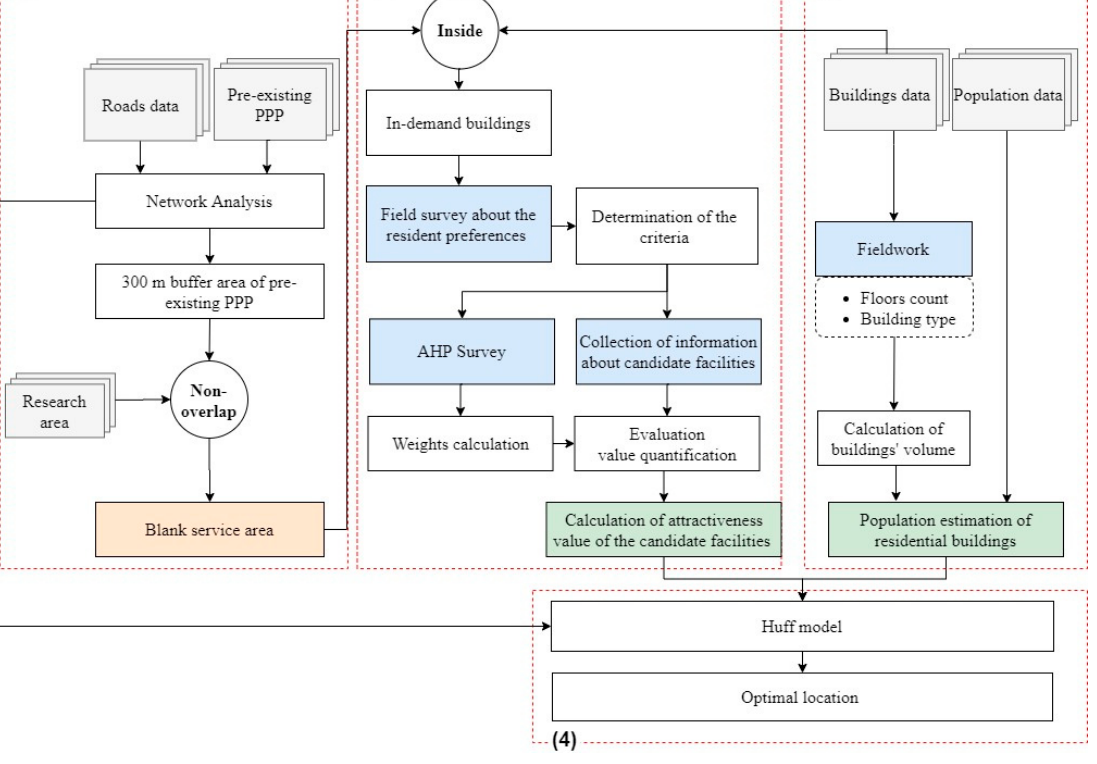
Figure 3. Methodological framework.